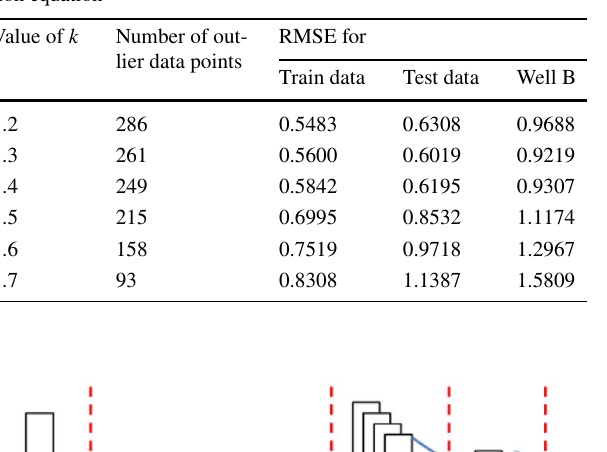
Table 9 Changes of RMSE value for the permeability modeling using the MELM-COA algorithm in the training, testing, and validation phases based on the changes in the value of k in the IQR determina-